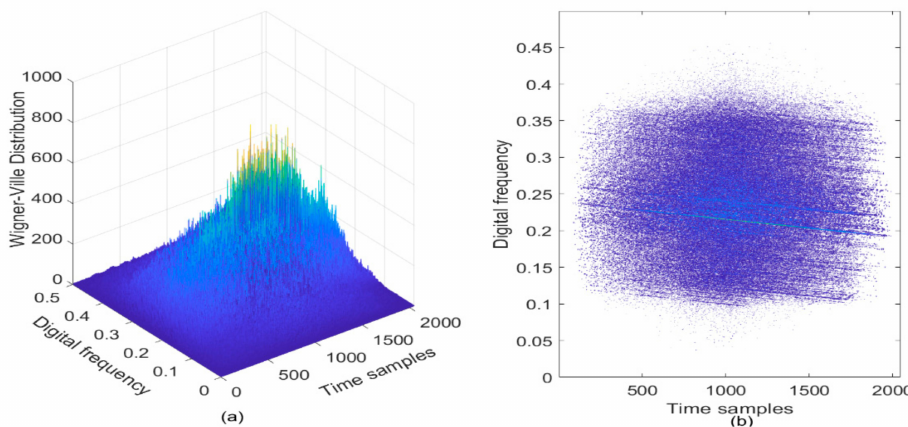
Figure 9. The WVD of the GPS L1-C/A signal in the presence of sweep interference. C / N 0 = 40 dB-Hz, JNR = − 2 dB. ( a ) WVD; ( b ) Contour of WVD.